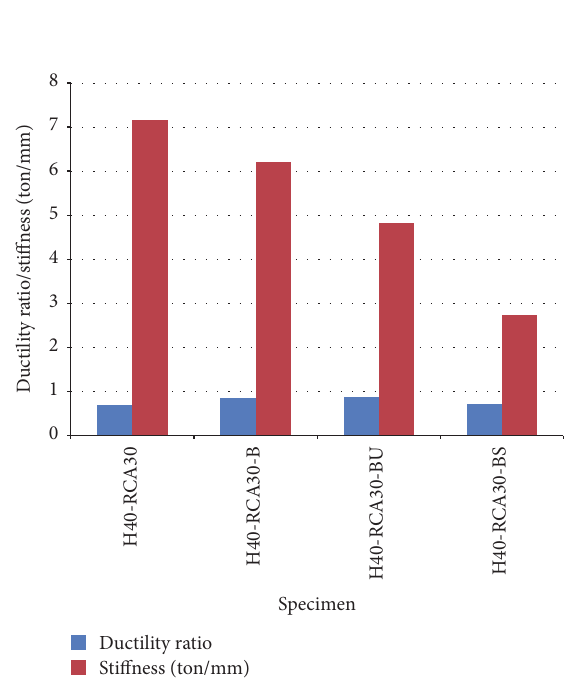
Figure 13: Comparison of rigidity ratio and ductility ratio by